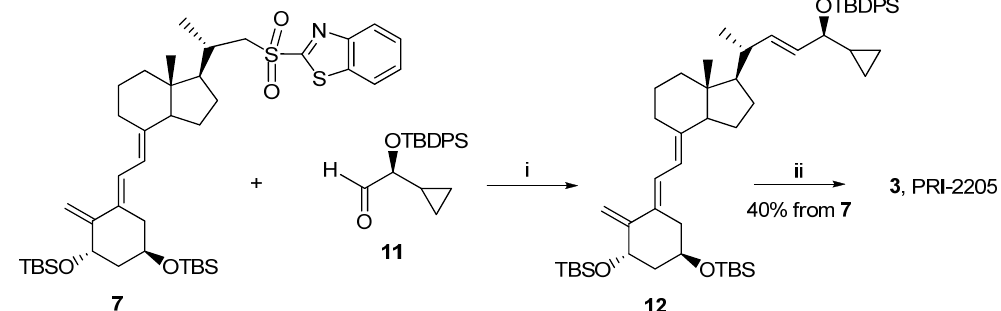
Scheme 3. The synthesis of the geometric analog 3 (PRI-2205) from the (5 E ,7 E )-benzothiazoyl sulfone 7 .